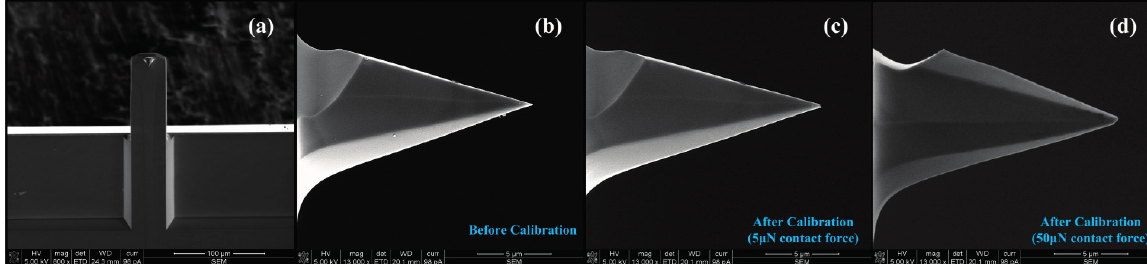
Figure 5. SEM images of a of NSC15_F probe before and after calibration. ( a ) is the bottom view of the cantilever; ( b ) is the side view of the tip before calibration; ( c , d ) are the side view of the tip after